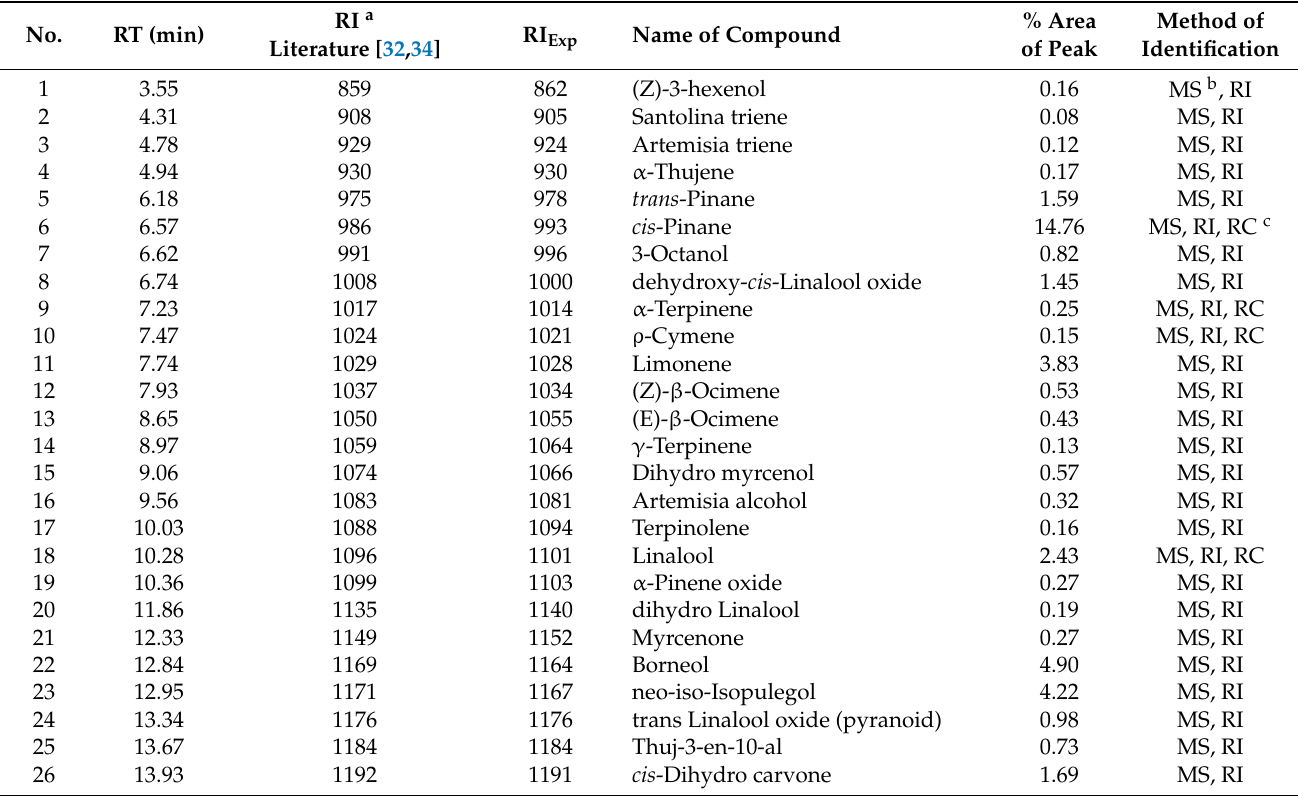
Table 1. Chemical composition and percentages of essential oil components from aerial parts of B. saxatilis from